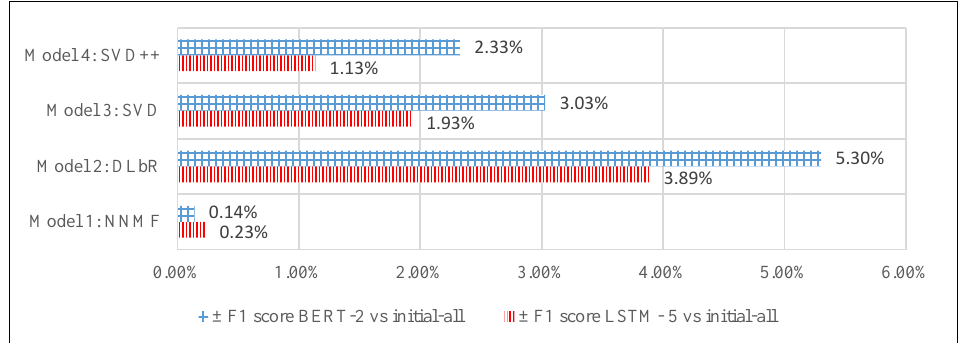
Figure 10. Comparison of the variations produced when using LSTM-5 or BERT-2 against the dataset 𝐷𝐴𝑇𝐴 𝑖𝑛𝑖𝑡.−𝑎𝑙𝑙 , of the four models in the F1 score parameter.